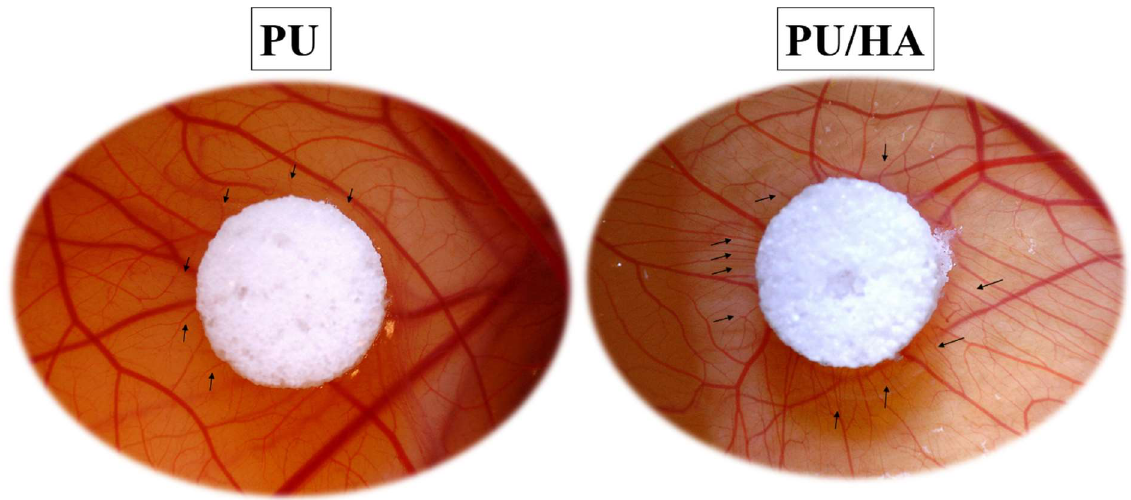
Figure 15. Comparison of new blood vessels forming around PU and PU/HA scaffolds. Scaffolds with HA has more arrows indicating blood vessels around the scaffolds compared to PU scaffolds.